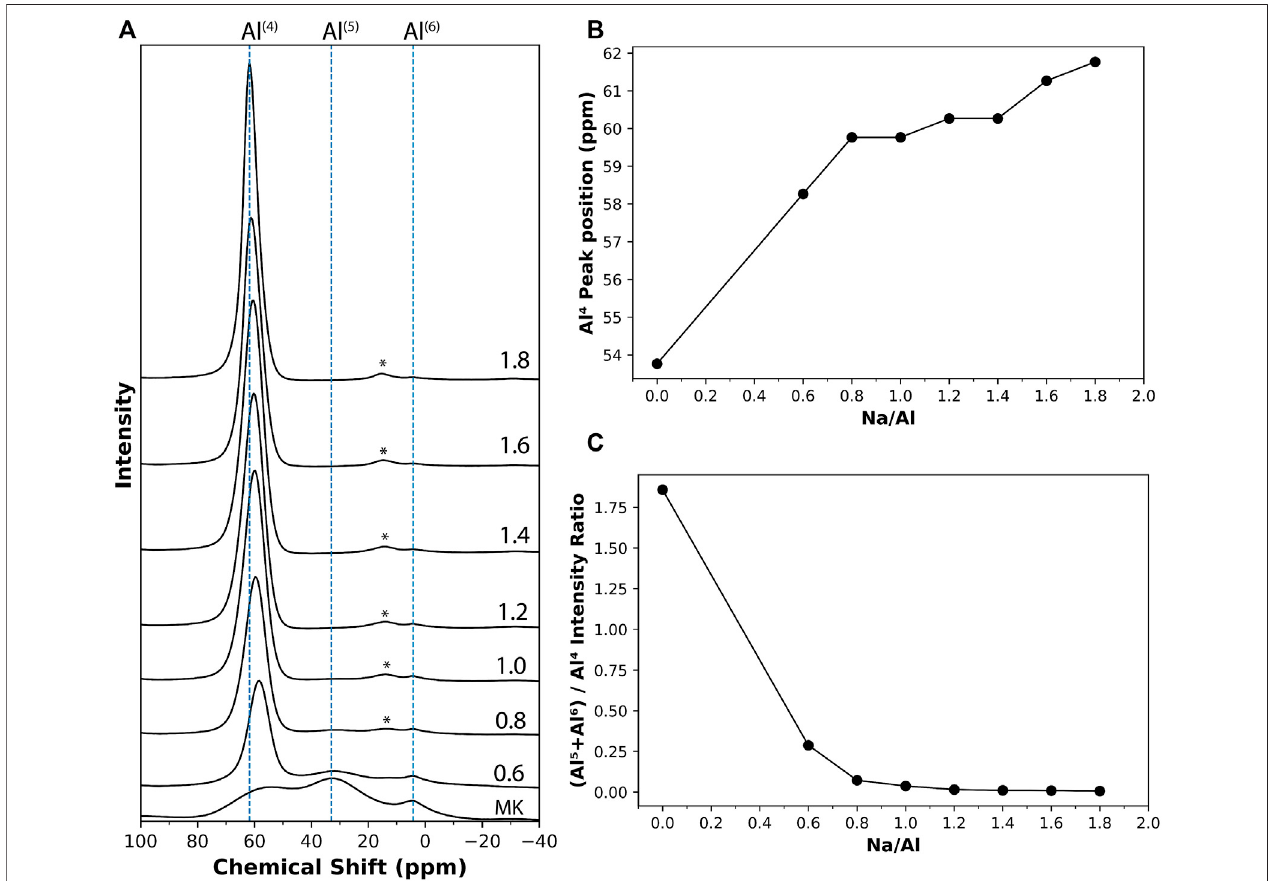
FIGURE 5 | (A) 27 Al solid-state MAS NMR results on metakaolin and different 4 month old AAM samples with varying Na/Al ratios (0.6 – 1.8), identi fi ed on each plot. The chemical shift values are referenced to Al(NO 3 ) 3 solution. The results were normalized according to the samples ’ weights. The peaks marked with (*) are spinning sidebands. (B) The change in the position of Al (4) peak with respect to the Na/Al ratio. (C) The Al (5) +Al (6) to Al (4) peak ratio for the different mixes.